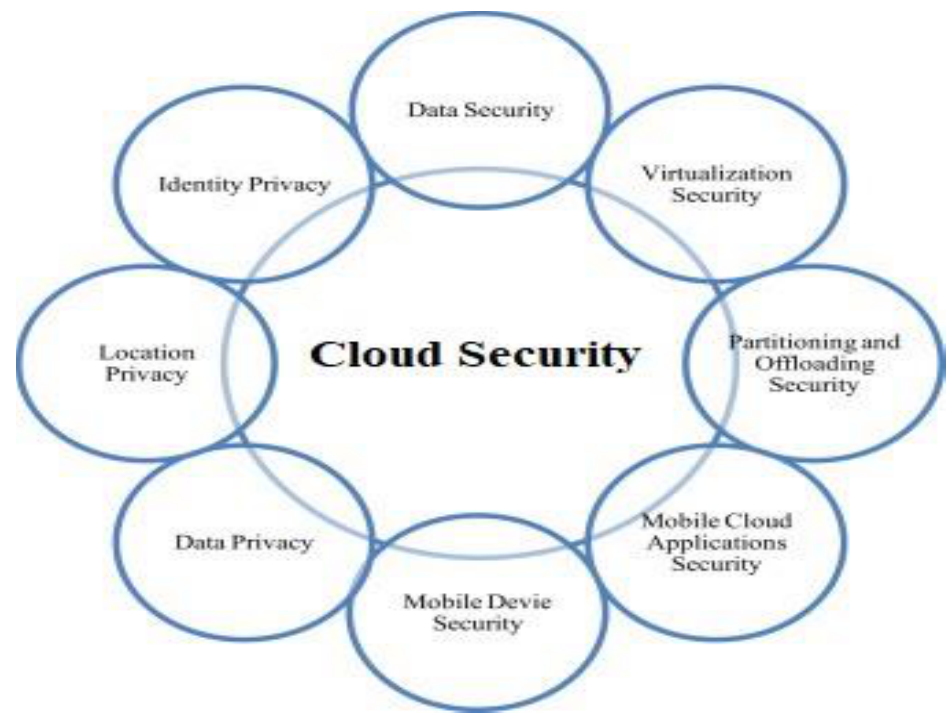
Figure 3 . Parts Affecting Cloud